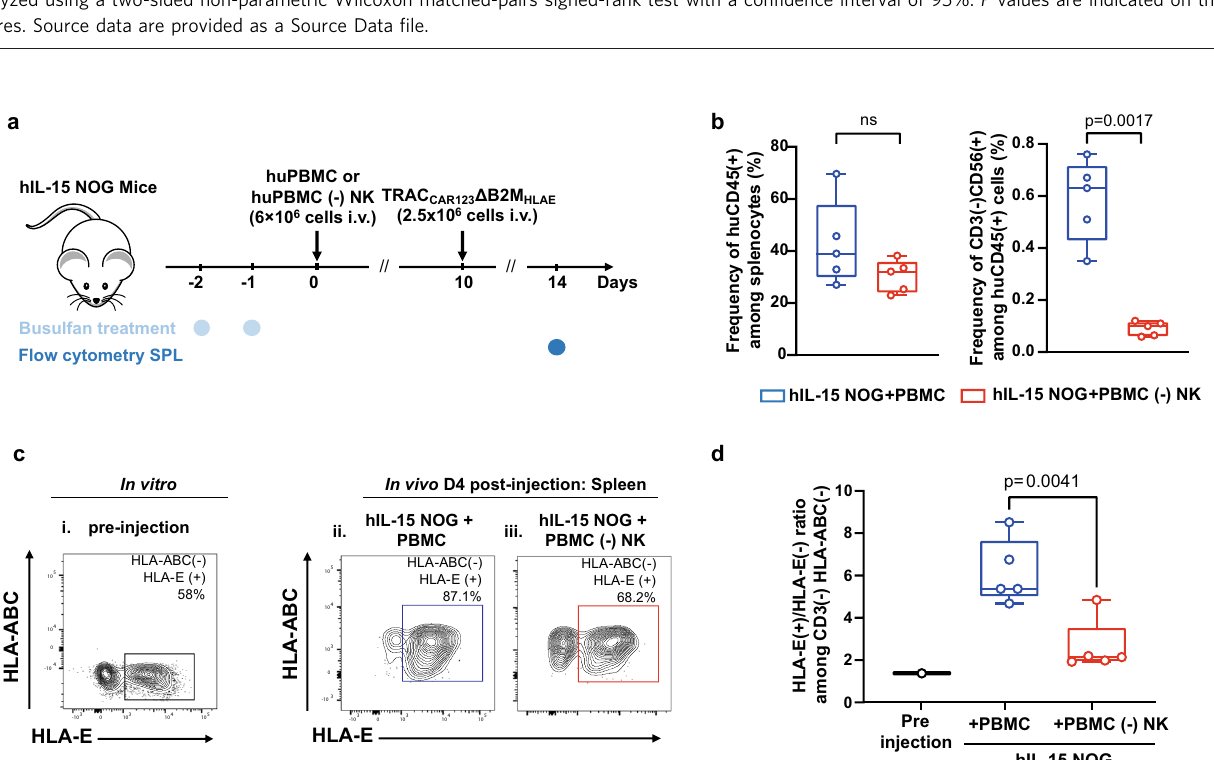
Fig. 6 The targeted insertion of HLA-E at the B2M locus allows for ef fi cient engraftment of Δ TRAC CAR Δ B2M HLAE in hIL-15 NOG mice adoptively transferred with human NK cells. a Strategy for assessing the resistance of Δ TRAC CAR123 Δ B2M HLAE T cells to NK cells in a xenotransplantation model using hIL-15 NOG mice intravenously injected with human PBMCs. b Quantitation of human CD45 + immune cell and CD56 + NK-cell engraftment in the spleen of hIL-15 NOG mice injected with human PBMCs ( n = 1 PBMC donor, n = 5 mice) or NK-depleted human PBMCs ( n = 1 PBMC donor, n = 5 mice). c Representative fl ow-cytometry plots showing the expression of HLA-E by Δ TRAC CAR123 Δ B2M HLAE T cells at the time of injection and 4 days post intravenous injection in PBMC-engrafted hIL-15 NOG mice. d Box plots representing the ratio of HLA-E( + )/HLA-E( − ) computed from the CD3( − )HLA- ABC( − ) subpopulations observed in ( c ) ( n = 5). For quantitative comparisons, data from ( b , d ), were analyzed using a two-sided parametric unpaired t test with a con fi dence interval of 95%. On each box plot, the central mark indicates the median, the bottom and top edges of the box indicate the interquartile range (IQR), and the whiskers represent the maximum and minimum data point. Each point represents the HLA-E( + )/HLA-E( − ) among CD3( − )HLA- ABC( − ) subpopulations obtain in one mouse. P values are indicated on the fi gures. Nonsigni fi cant P values are indicated as “ ns ” . Source data are provided as a Source Data fi evade the cytolytic activities of NK cells and alloresponsive CD8( + ) insertion (CAR and HLA-E). We forecasted that this strategy would T cells. To achieve this goal, we aimed to prevent HLA Class-I expression in CAR T cells by inactivating B2M and to endow these cells with a surface-exposed NK inhibitor (HLA-E). We also con- simultaneous double knockout by knock-in strategy. The combina- sidered the inactivation of TCR αβ to prevent GvHD, a major risk of allograft transplants. We reasoned that TRAC and B2M genes could design of AAV6 repair matrices enabled us to obtain a high be concomitantly inactivated and used as landing pads for transgene